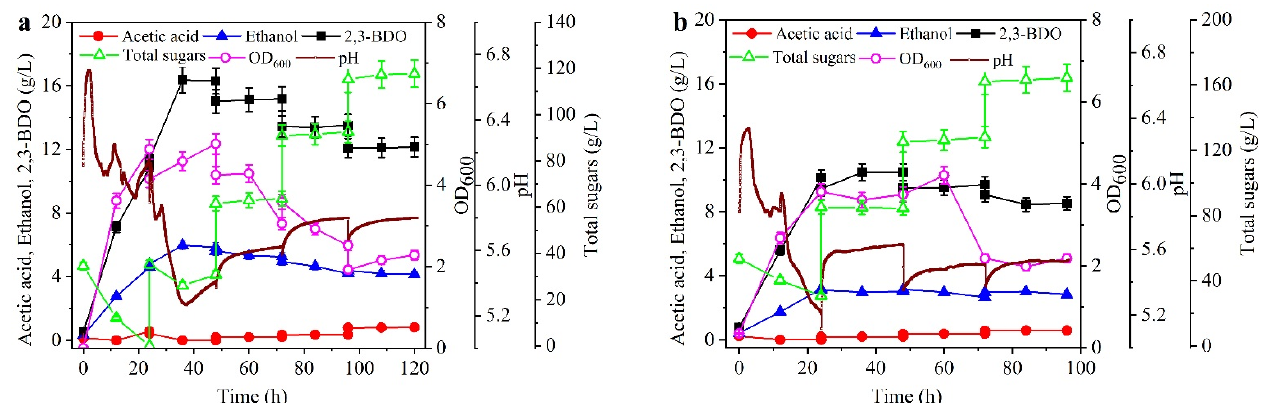
Figure 5. Effect of fed-batch culture on 2,3-BDO production. The time courses refer to ( a ) an initial 35 g/L total sugars with a final concentration of 35 g/L total sugars in the broth from each fed-solution, and ( b ) an initial 55 g/L total sugars with a final concentration of 55 g/L total sugars in the broth from each fed-solution. The cultures were carried out in a 2.7 L bioreaction. Data are given as the mean ± SD, n = 2.